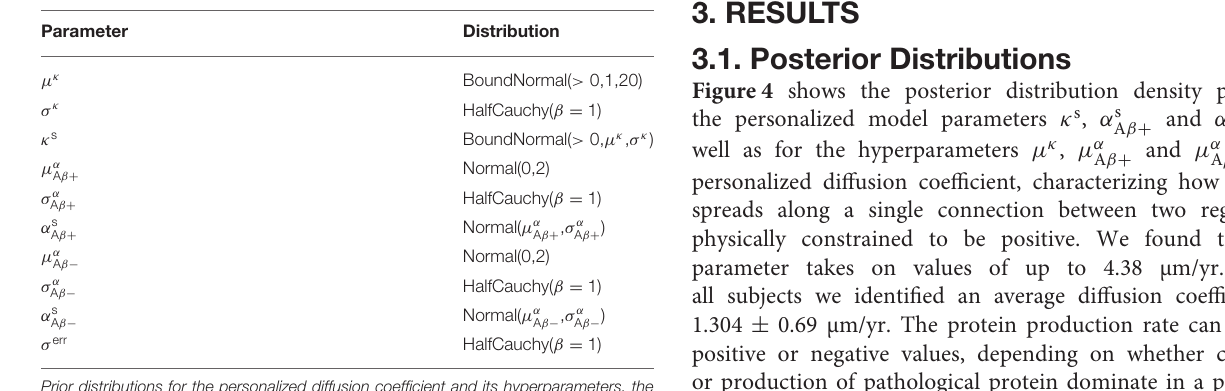
Frontiers in Physiology |